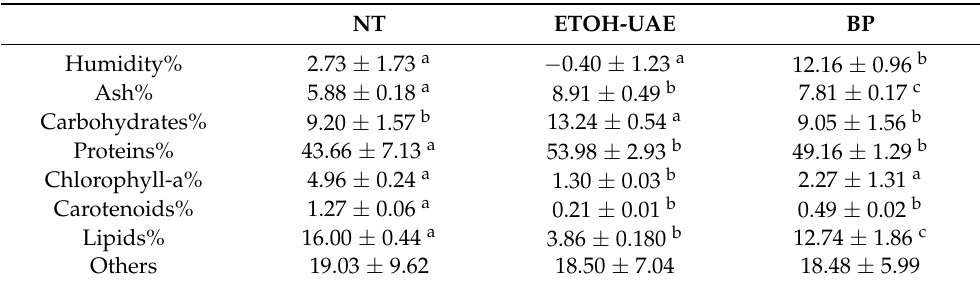
Table 4. Humidity after freeze-drying and proximate composition in dry weight basis of nontreated and residual biomass after EtOH-U Α E and BP extraction.